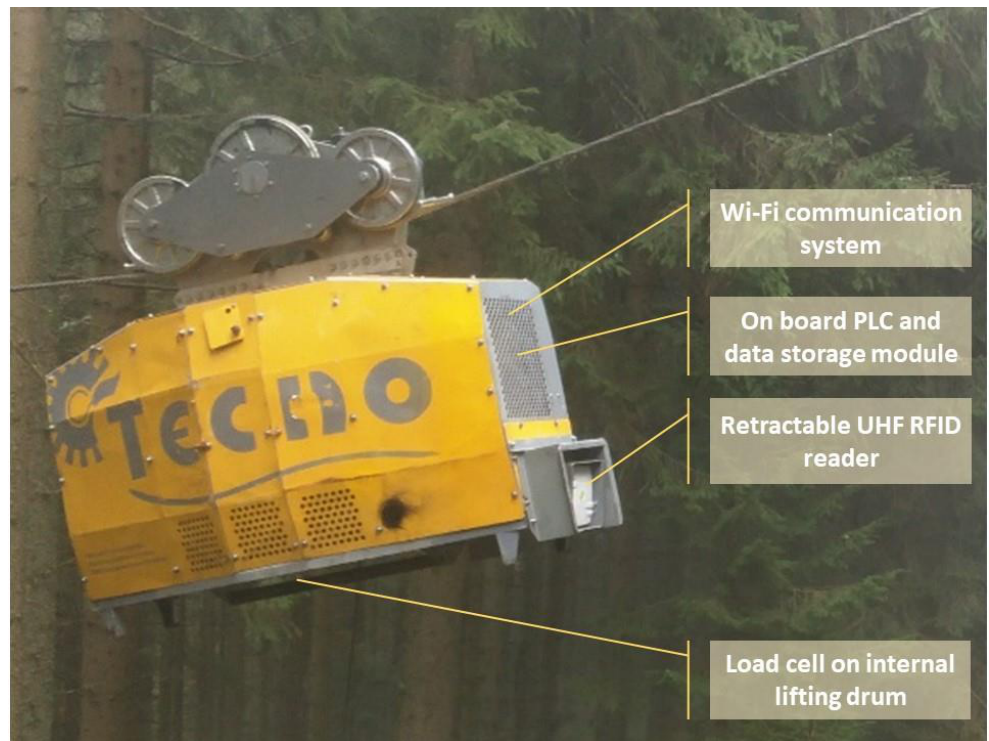
Figure 3. Modified self- propelled carriage “Greifenberg Tecno Power . ”